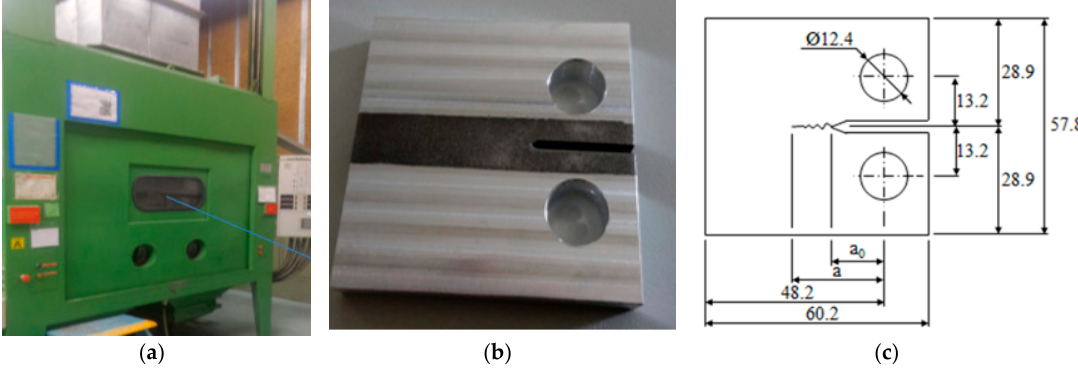
Figure 1. ( a ) Shot peening machine; ( b ) shot peened specimen; and ( c ) dimensions of Compact Tension (CT) specimens in mm.